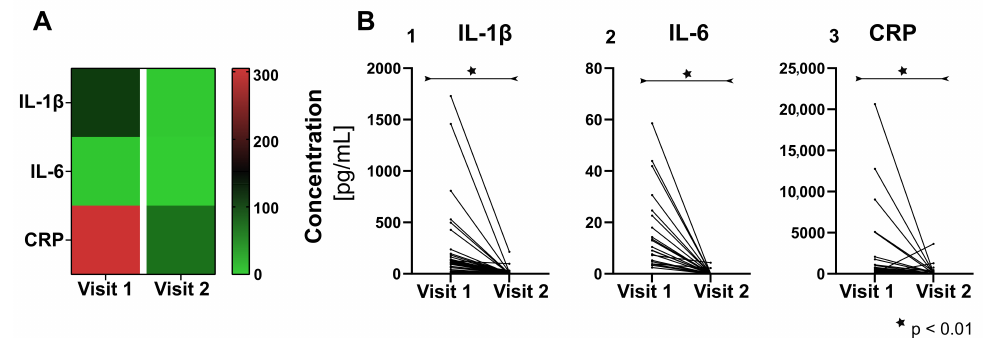
Figure 2. Position of the bodies reference frames within the PAQUITOP kinematic structure. Figure 2. Changes in the concentration of the cytokines Interleukin (IL)–1 β , IL-6, and C-reactive protein (CRP) between visit 1 and visit 2 for all groups. ( A ) Heatmap giving an overview over the medians and ( B ) diagrams on the single-sample level for concentrations of IL-1 β (graph 1 of Figure 2B), IL-6 (Graph 2) and CRP (Graph 3).